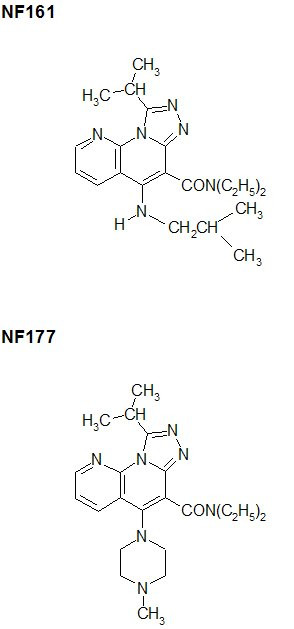
Structures of NF161 and NF177.